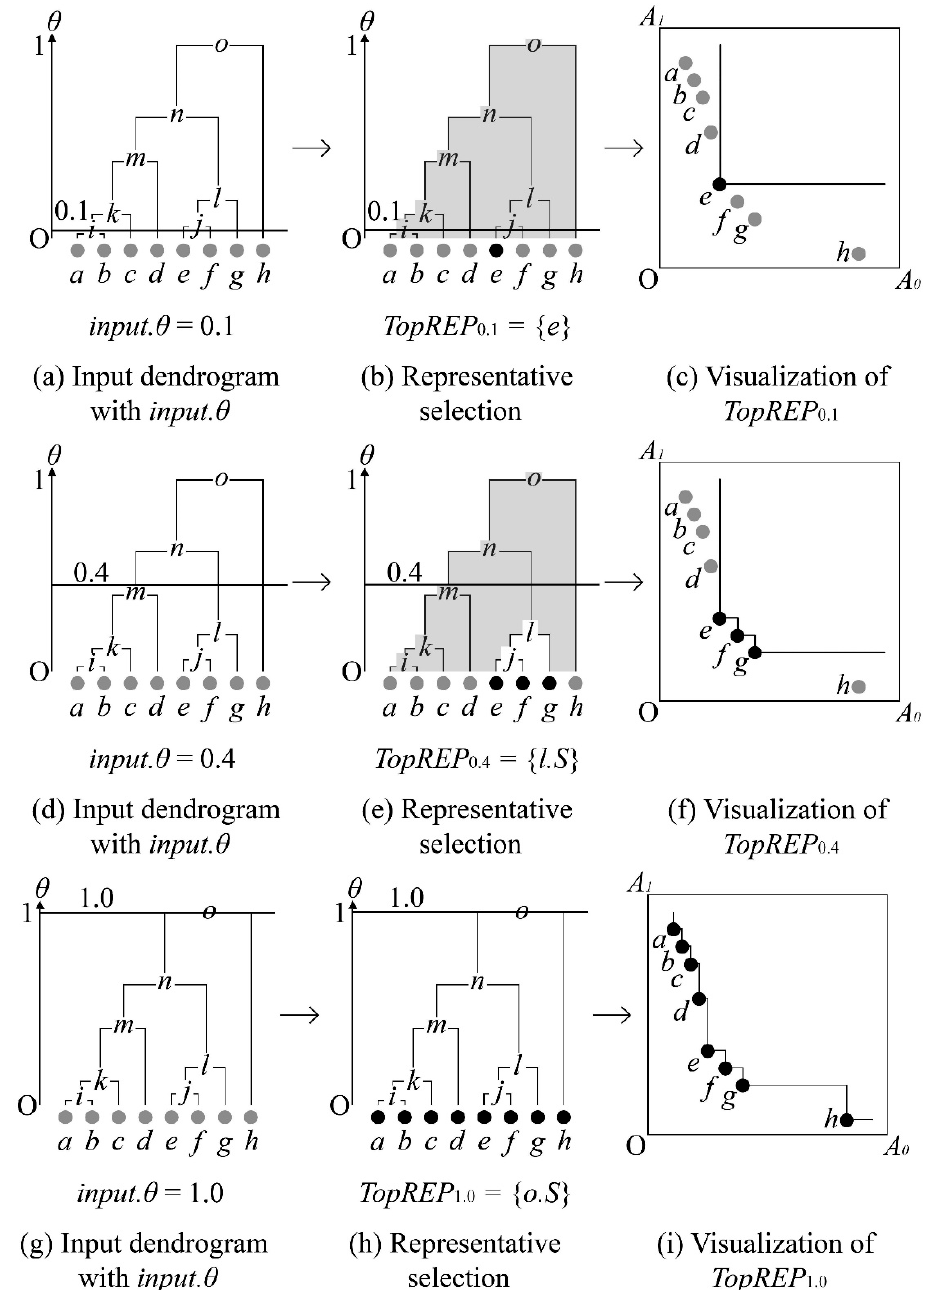
Figure 6. An example of top representative skyline points selection.